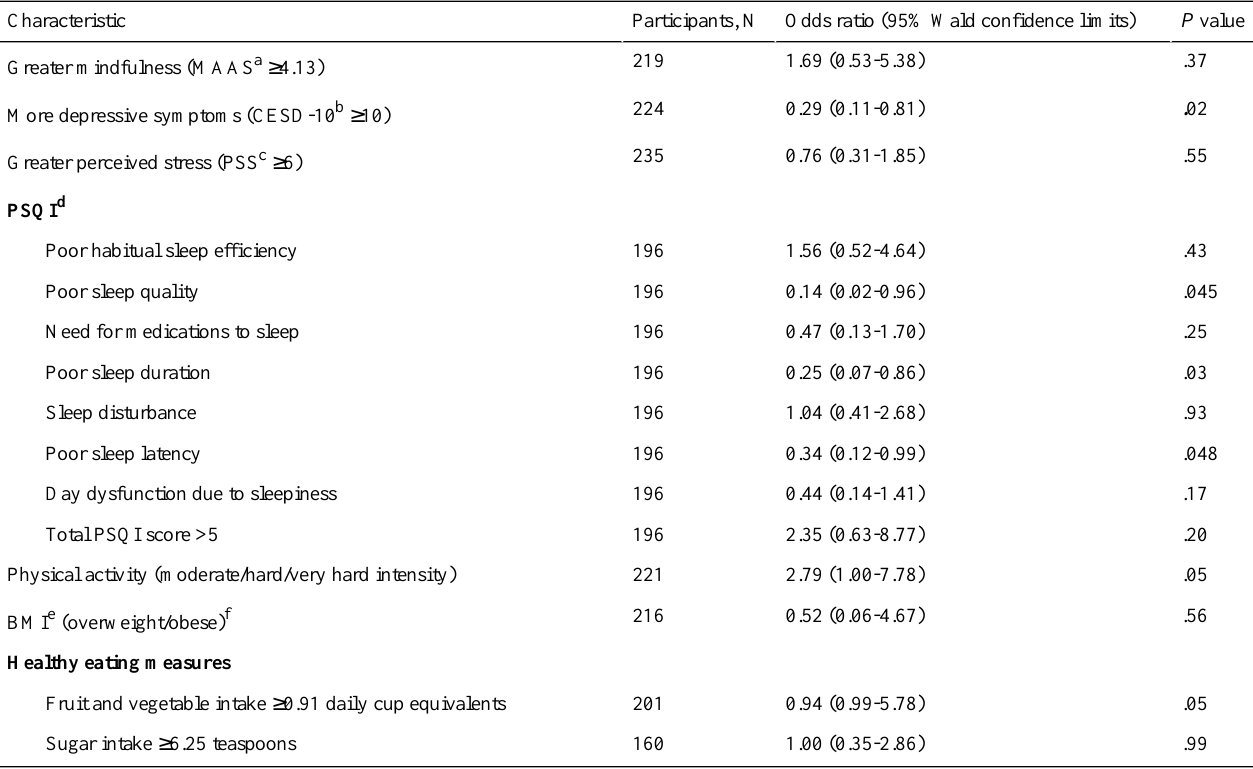
Table 4. Individual logistic regression models predicting the effect of the program on outcome at follow-up, adjusted for number of days app was used, and outcome at